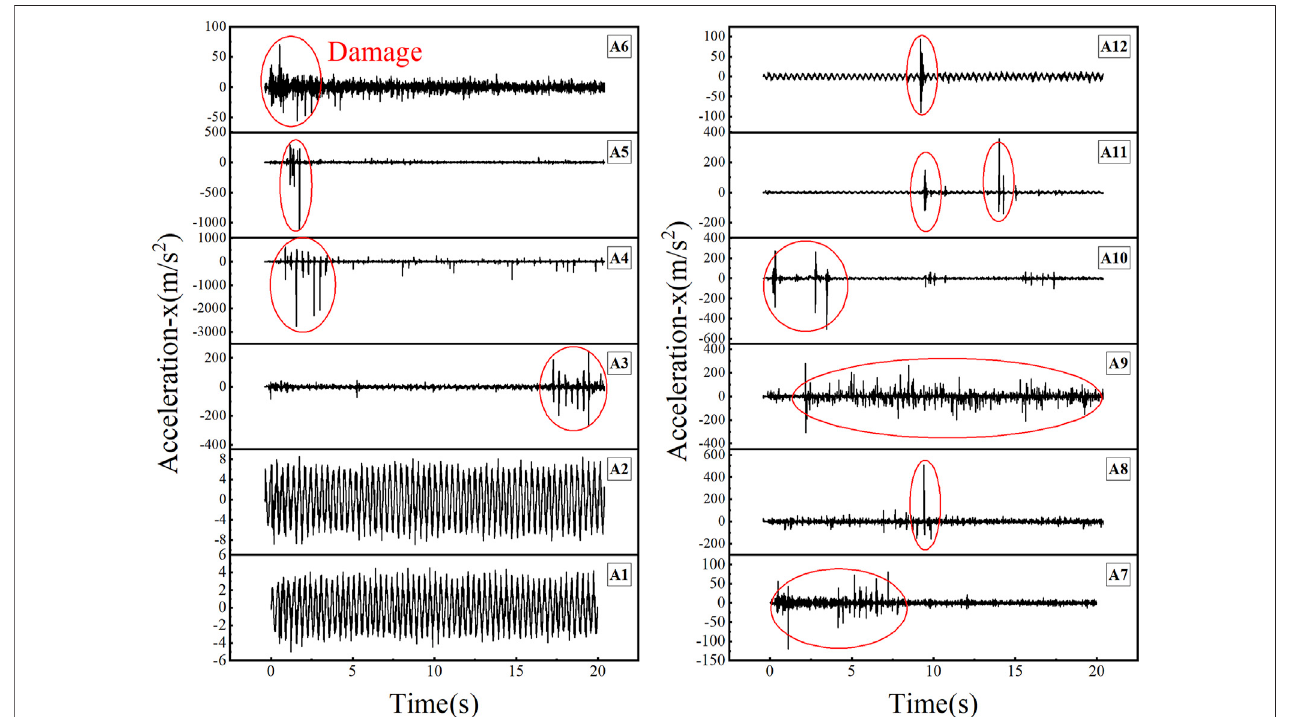
FIGURE 9 | Acceleration time-history curve of calculation condition with weak interlayers of 15 ° and ampli fi cation of 0.5 g.